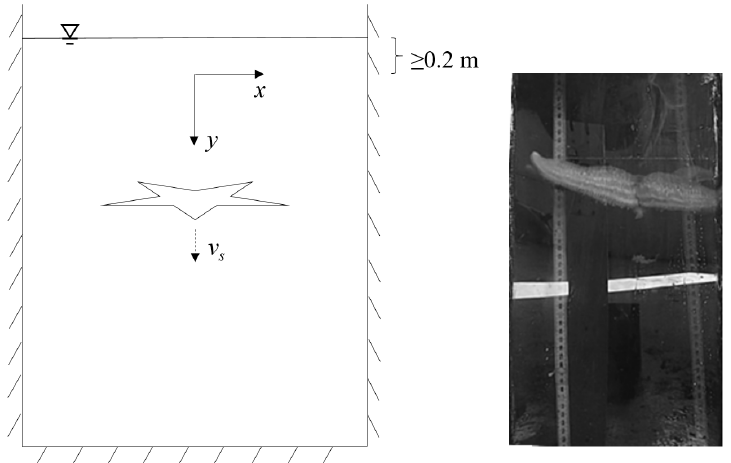
Figure 2. Sketch and snapshot of the settling velocity